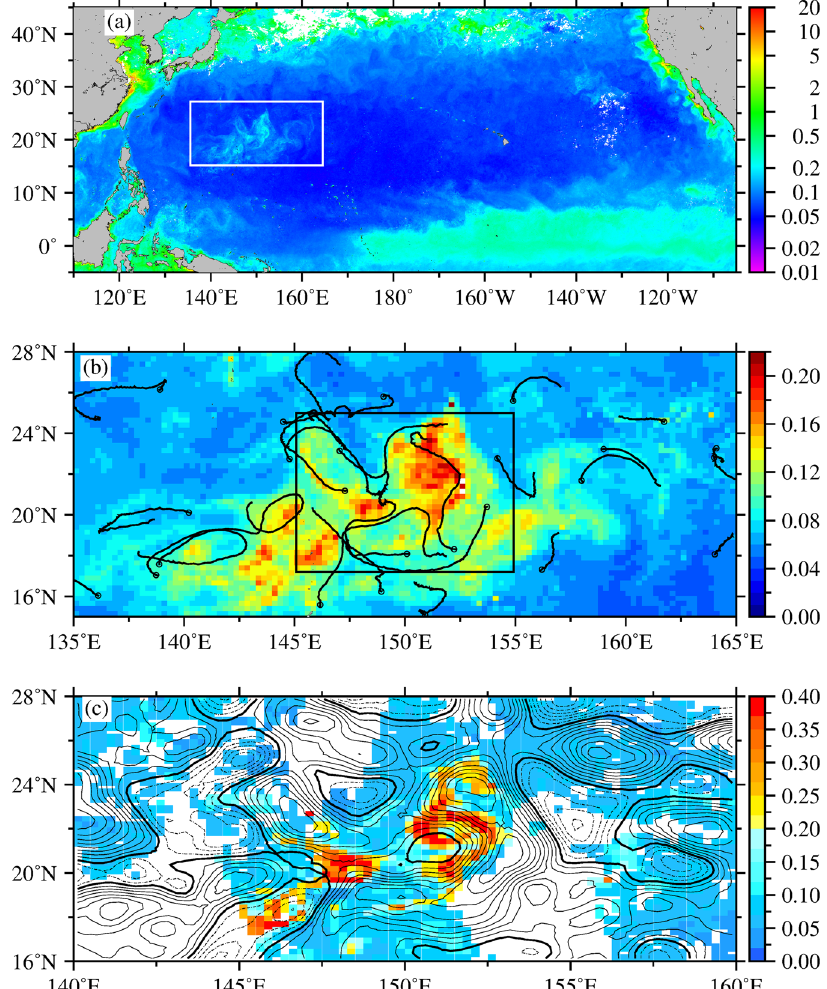
Figure 1. ( a ) Satellite Chl concentration (mg/m 3 ) for the NPSG in July 2003 with white bracket showing the bloom area located at the western NPSG. ( b ) Closed up map of the bloom area from July 4 to August 4, 2003. The black curves in ( b ) show the trajectories of surface Argos drifters from July 4 to August 4 of 2003, and the circles at one end of the curves show the drifter locations on July 4. ( c ) SSHAs (contour interval: 4 cm, dashed: negative, solid: positive, bold solid: zero) and Chl (colors) on July 12, 2003. This figure was generated using open source Generic Mapping Tools 33 (Ver. 5.3.0